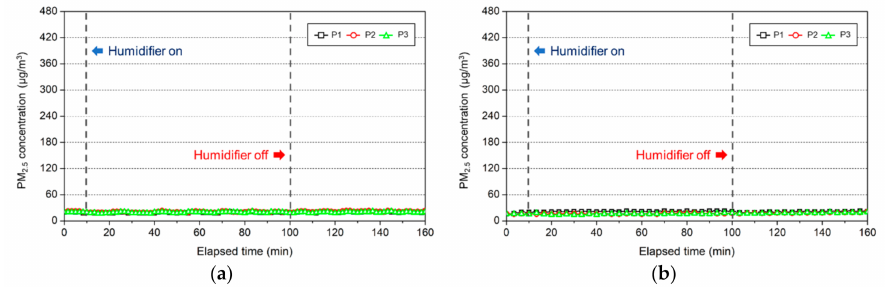
Figure 11. PM 2.5 concentration according to the use of a natural evaporative humidifier for each water type: ( a ) tap water (Seoul); ( b ) distilled water.